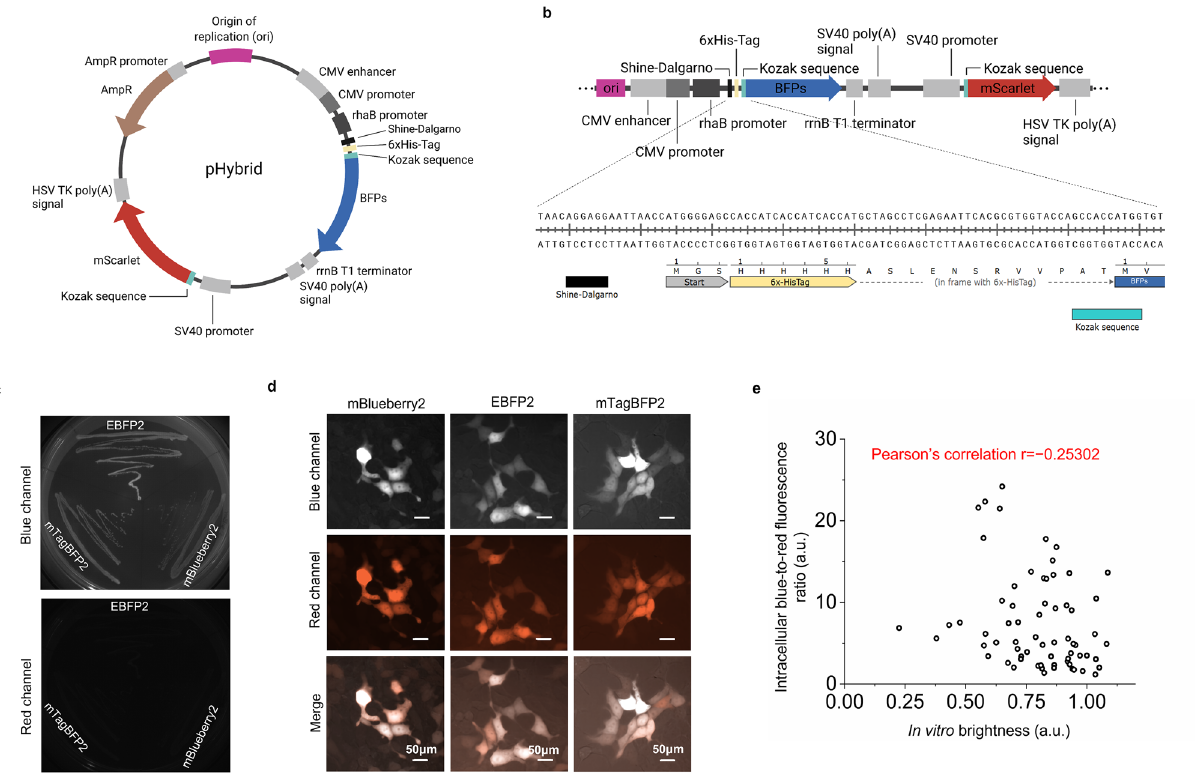
Figure 1. Development and validation of new pHybrid expression vector. ( a ) pHybrid-BFP-mScarlet vector map. Introduction of a new hybrid vector for bacterial and mammalian expression of target gene using mScarlet as reference gene. ( b ) pHybrid linear map showing basic features of pHybrid vector: (top) origin of replication, BFPs under CMV promoter and rhaB promoter for expression in mammalian cells and E. coli , respectively, followed by rrnB T1 terminator and SV40 poly-A tail, mScarlet under SV40 promoter regulation followed by HSV TK poly-A tail; (bottom) nucleotide sequence of the SD sequence, His-tag and Kozak sequence elements in front of the BFP gene. ( c ) Fluorescence images of E. coli bacteria transformed with pHybrid-mBlueberry2/ mScarlet (mBlueberry2), pHybrid-EBFP2/mScarlet (EBFP2), and pHybrid-mTagBFP2/mScarlet (mTagBFP2) expression vectors in blue (top) and red (bottom) channels (imaging conditions: 403 nm/456 nm excitation/ emission for blue, ex/em 561 mn/594 nm for mScarlet). ( d ) Fluorescence images of HEK cells transfected with pHybrid-mBlueberry2/mScarlet (mBlueberry2), pHybrid-EBFP2/mScarlet (EBFP2), and pHybrid-mTagBFP2/ mScarlet (mTagBFP2) expression vectors in blue (top), red channel (middle) and merged (bottom) (imaging conditions: 403 nm excitation, 456 nm emission for BFPs; 561 nm excitation, 594 nm emission for mScarlet, 0.91 mW/mm 2 power). The dynamic range of all images was adjusted independently to facilitate visualization. ( e ) Correlation of HEK intracellular brightness and in vitro brightness for blue fluorescence variants selected from the random library of BFP derived from mRuby3 (see Supplementary Table S1 for statistics; Pearson’s correlation shown in graph; imaging conditions of HEK same as in ( d)